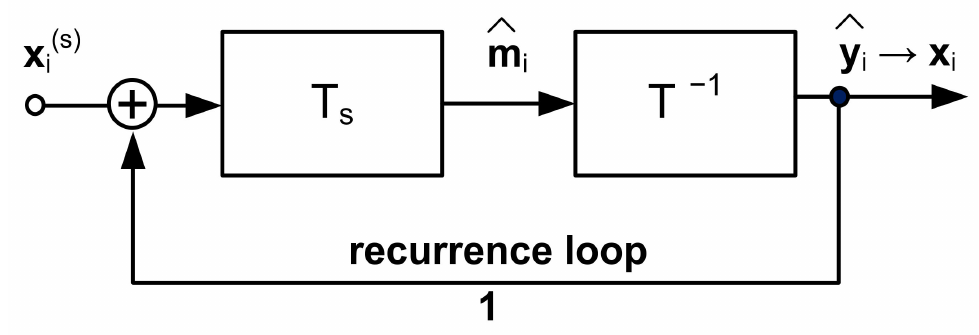
Figure 1. Structure of the machine learning model for image processing.